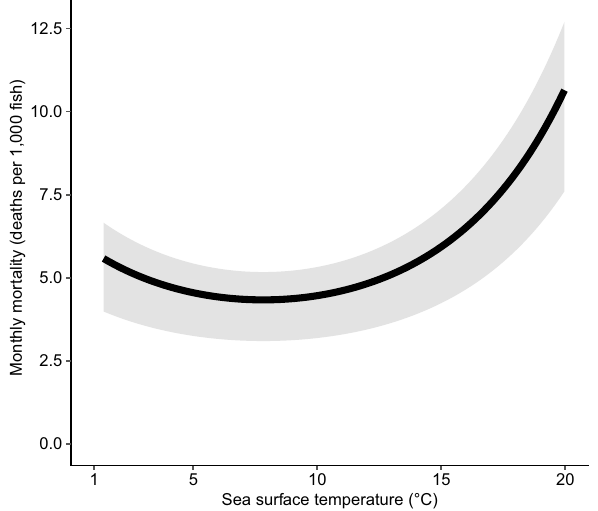
Figure 4. Atlantic salmon mortality predictions from the final model based on sea surface temperature. The lines and shaded areas in the plots show the mean and interquartile range of predicted values, respectively. This figure was generated using the Tidyverse 46 package in R 47 .